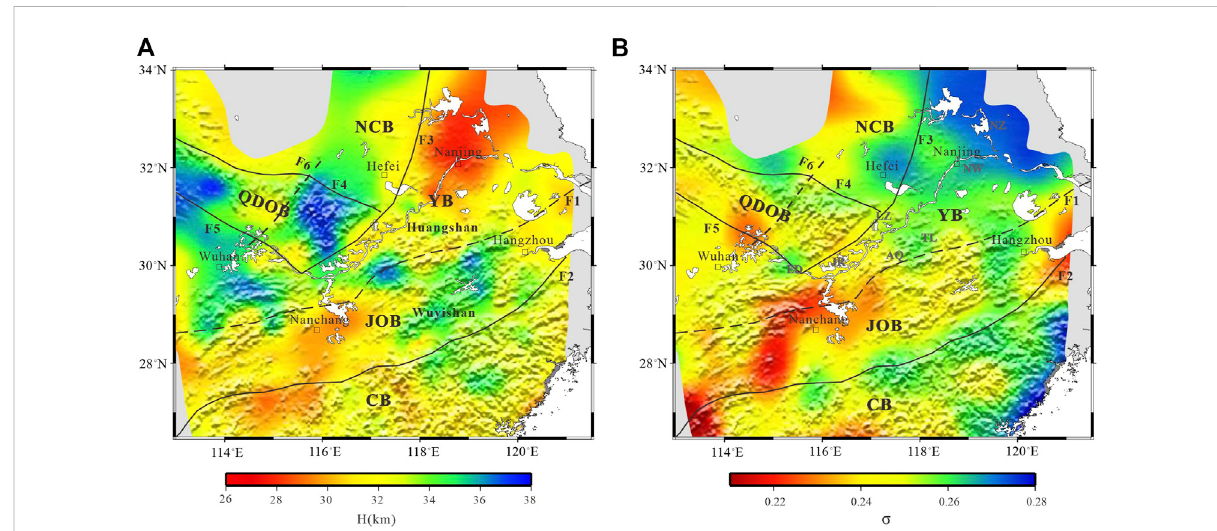
FIGURE 7 Two-dimensional distribution map of crustal thickness (A) and Poisson ’ s ratio (B) in the study area. NZ, Ningzhen deposits; NW, Ningwu deposits; LZ, Luzong deposits; AQ, Anqing deposits; TL, Tongling deposits; JR, Jiurui deposits; ED, Southeastern Hubei deposits. F6, Shangcheng- Machang fault. Labels are the same as in Figure 1.